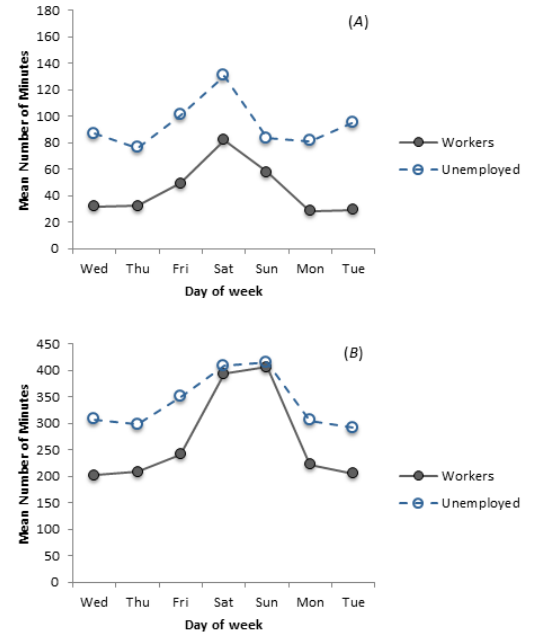
Figure 3: Time with ( A ) friends and ( B ) family by day of week. From American Time Use Survey, 2003–11.